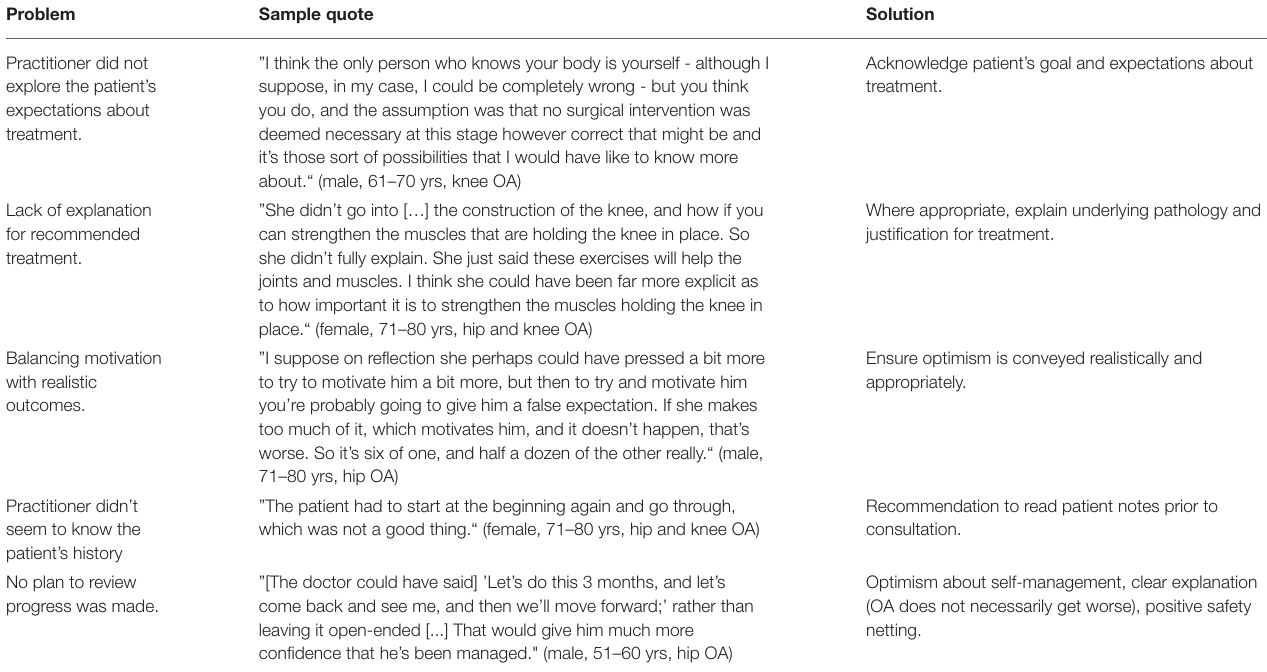
TABLE 6 | Problems with the Empathico consultation from patients’ perspectives. Problem Sample quote Solution Practitioner did not explore the patient’s expectations about